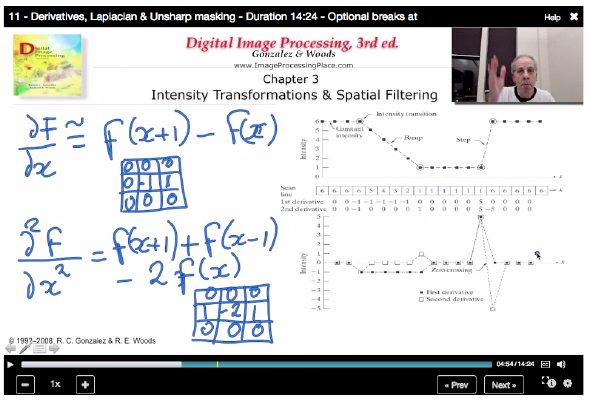
Figure 7: Image and Video Processing